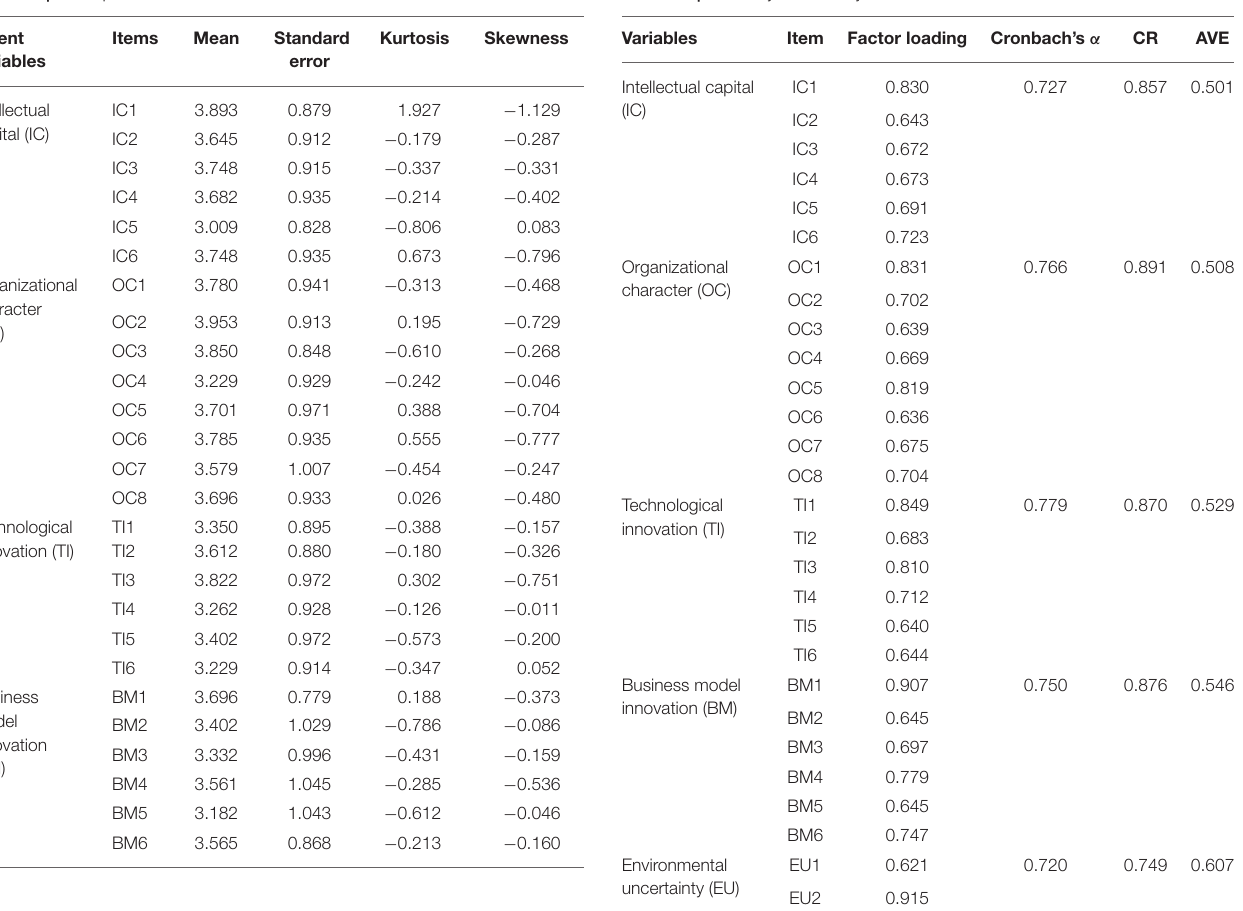
TABLE 2 | Descriptive statistics of latent variables. TABLE 3 | Reliability and validity